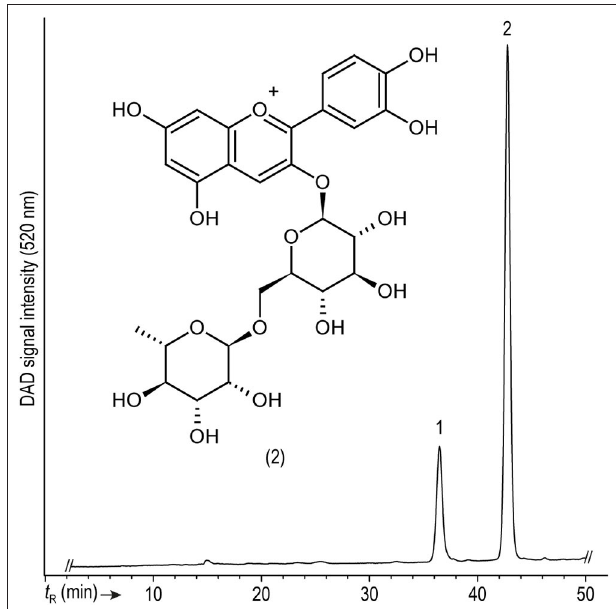
FIGURE 2 | Representative HPLC-DAD chromatogram showing the separation of anthocyanins present in the peels of Caturra Rojo (red variety) monitored at 520nm. For peak assignment, see Table 3 .